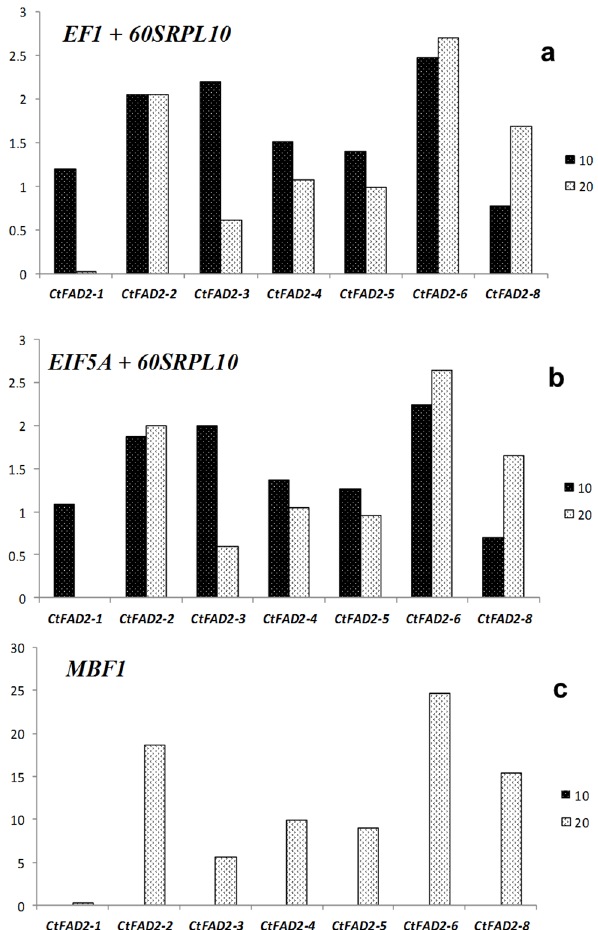
Fig 6. Relative quantification of 7 CtFAD2 genes using different combinations of RGs or single RGs for normalization. a. Gene expression normalized with the most stable RGs selected by geNorm for the low temperature stress samples. b. Gene expression normalized with the most stable RGs selected by NormFinder for low temperature stress samples. c. Gene expression normalized with the most unstable genes selected by both geNorm and NormFinder for low temperature stress